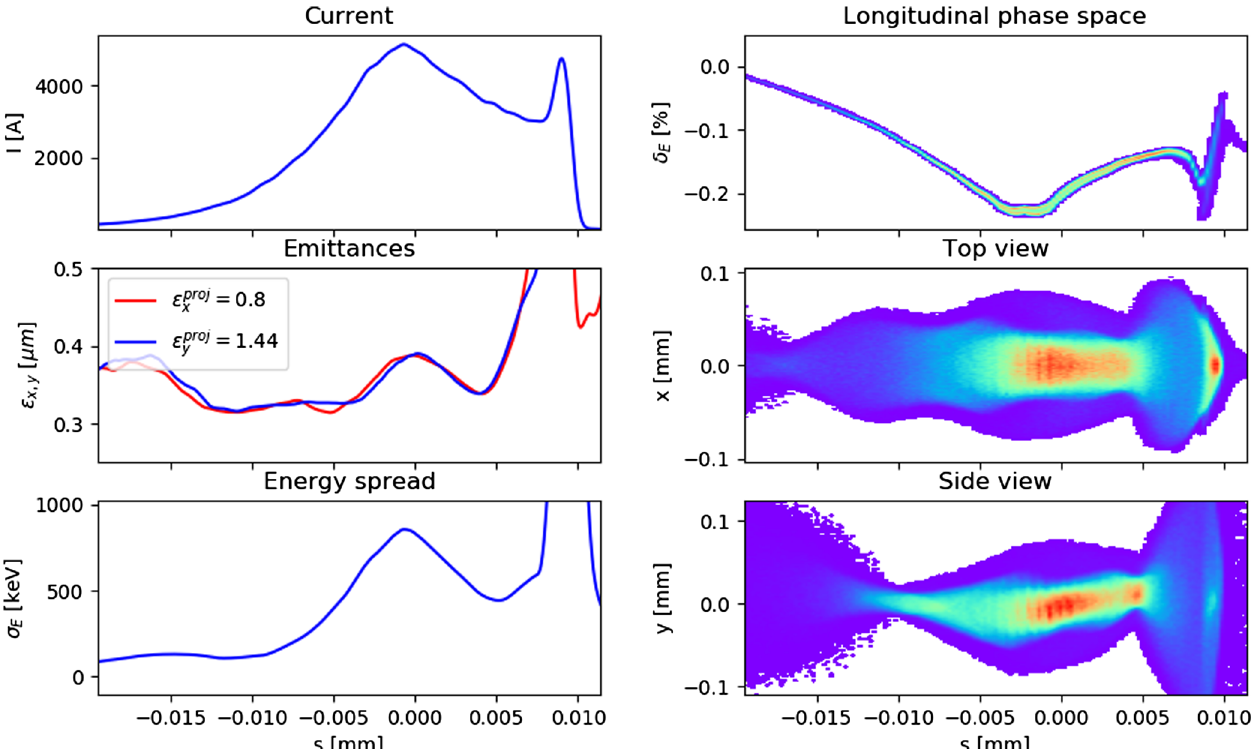
FIG. 10. The properties of the bunch with a charge of 250 pC compressed to 5 kA peak current at the SASE1 line undulator entrance.